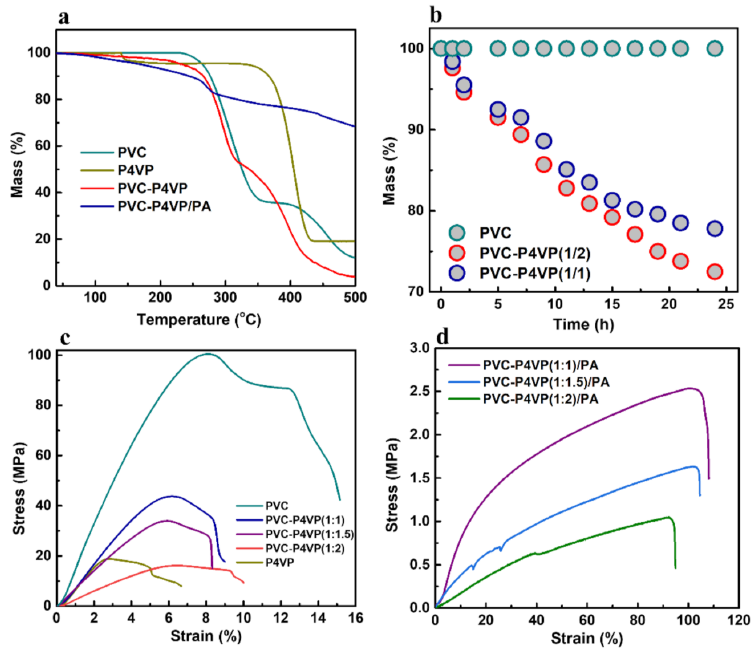
Figure 4. ( a ) TGA curves of PVC, P4VP, PVC-P4VP and PVC-P4VP/PA membranes in N 2 , ( b ) mass changes of PVC, PVC-P4VP(1/2) and PVC-P4VP(1/1) immersed in Fenton’s reagent at 68 ◦ C, tensile stress-strain tests of ( c ) PVC, P4VP, PVC-P4VP(1:1), PVC-P4VP(1:1.5) and PVC-P4VP(1:2) membranes and ( d ) PVC-P4VP(1:1)/PA, PVC-P4VP(1:1.5)/PA and PVC-P4VP(1:2)/PA